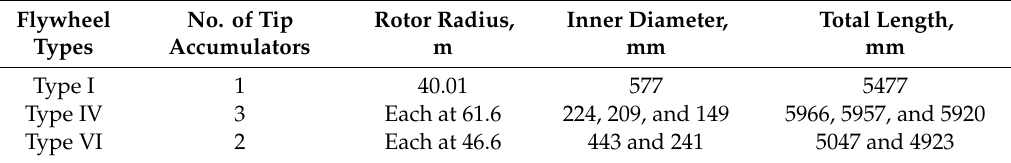
Table 3. Properties of the CFRP piston accumulators of the three FW